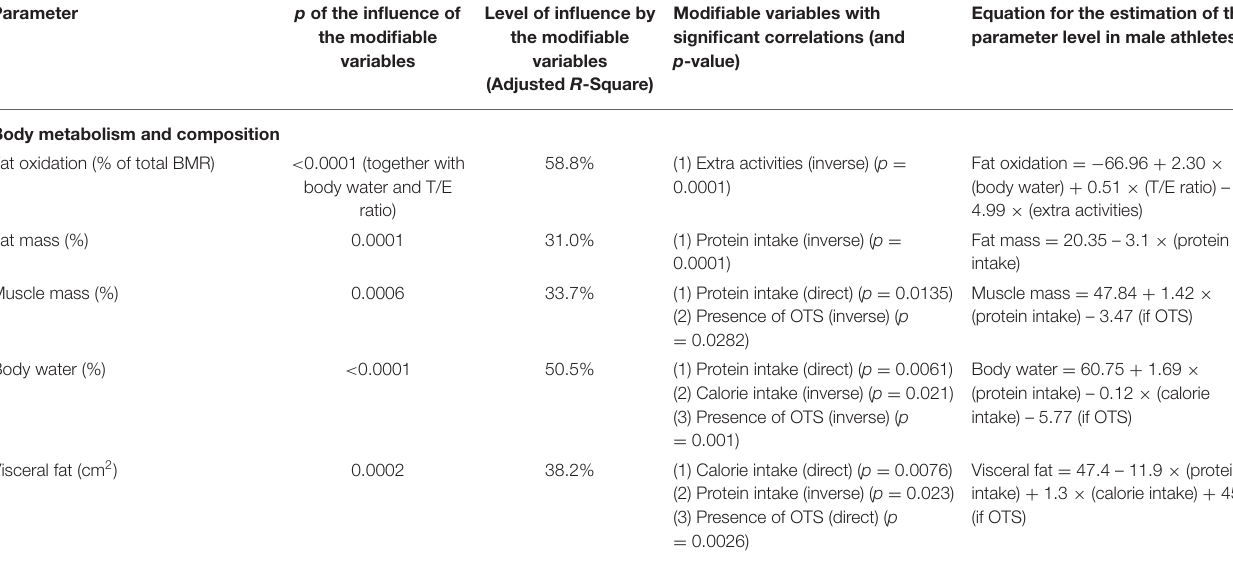
Equation for the estimation of the parameter level in male athletes